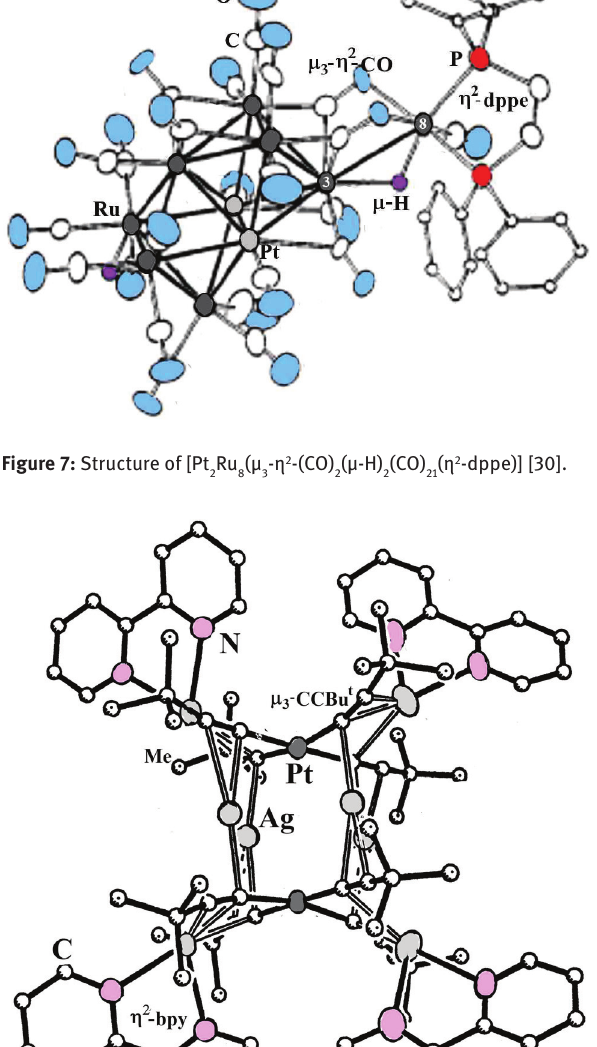
Ag (µ - ≡ CBu t ) 2 4 3